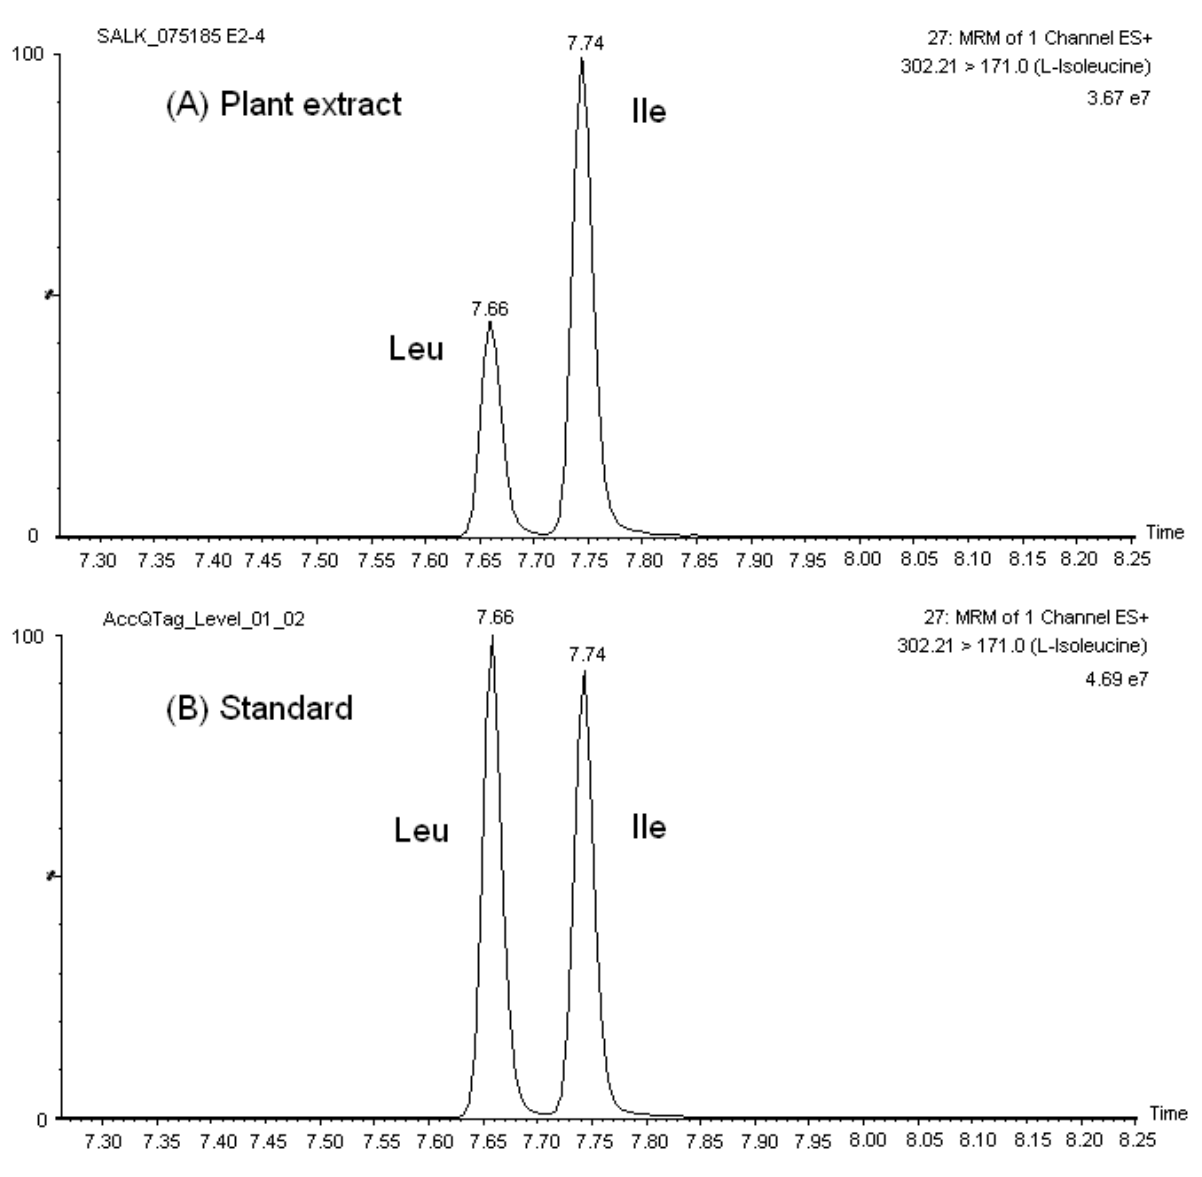
Figure 1. Mass chromatographs of the isobaric set Leu/Ile in ( A ) A. thaliana extract, and ( B ) calibration solution (25 μ